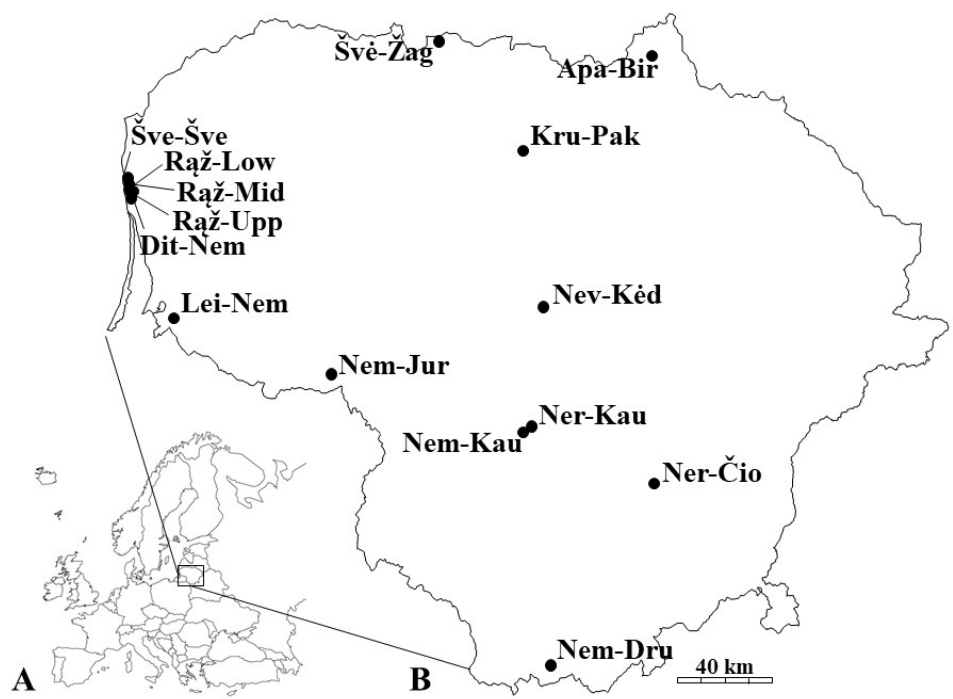
Figure 1. Location of Lithuania ( A ), and 15 sites with purple loosestrife ( Lythrum salicaria ) growing in the country ( B ).